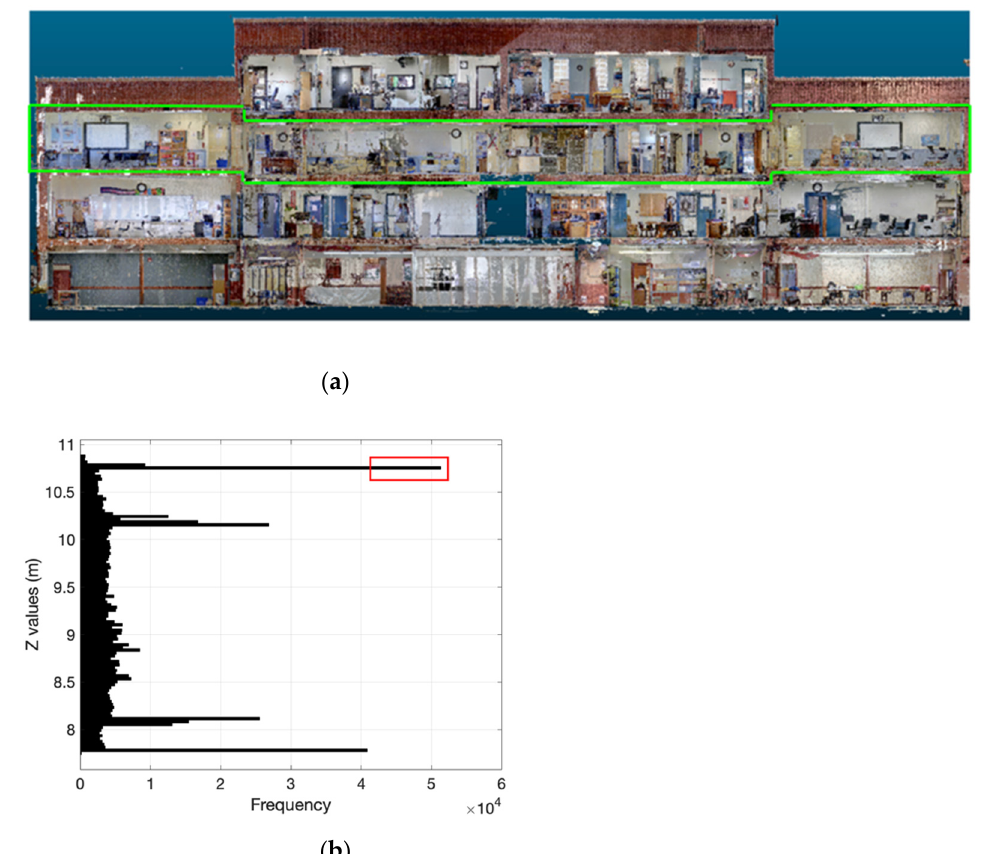
Figure 12. ( a ) Cross section of Old Sun Main Building with Storey 3 outlined in green; ( b ) Vertical histogram for Old Sun Main Building Storey 3 where multi-level floor and ceiling slabs are present, overlapping floor and ceiling segment outlined in red.